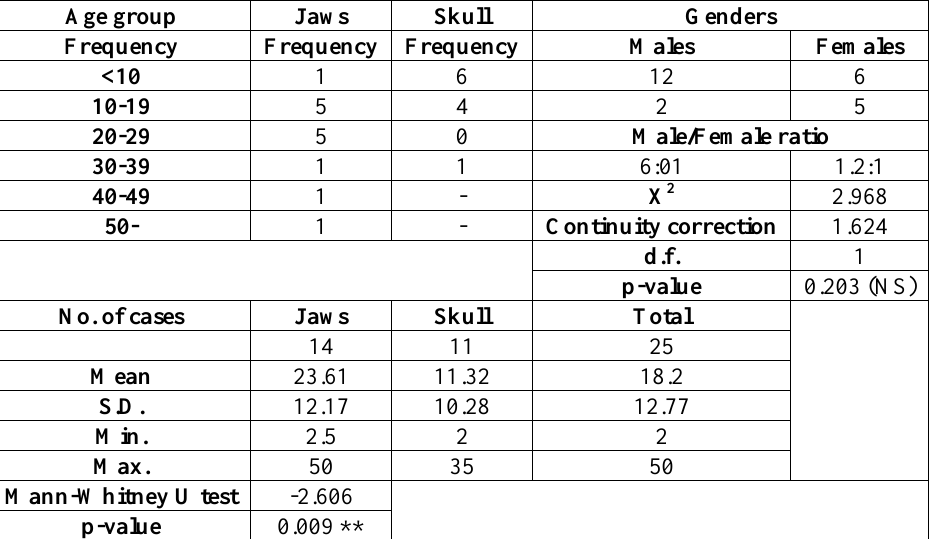
Table 1: Frequency Distribution and Percentage of Age and Genders Age